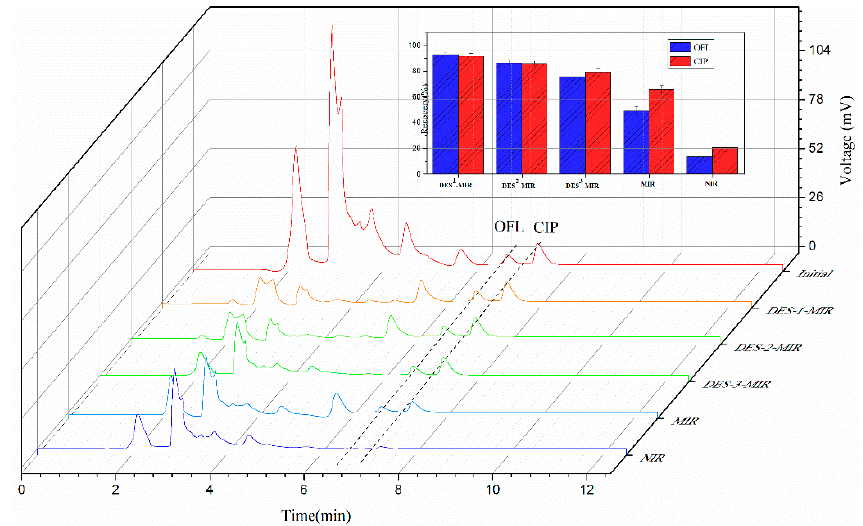
Figure 7. Chromatograms and recoveries of different adsorbents including (NIR, MIR, DES 1 -MIR, DES 2 -MIR and DES 3 -MIR). Table 3. Isotherm model parameters for MIR, DES 1 -MIR, DES 2 -MIR and DES 3 -MIR on OFL adsorption. Table 4. Parameters of OFL adsorption towards DES 1 -MIR and MIR from two kinetic models. Isotherm Model